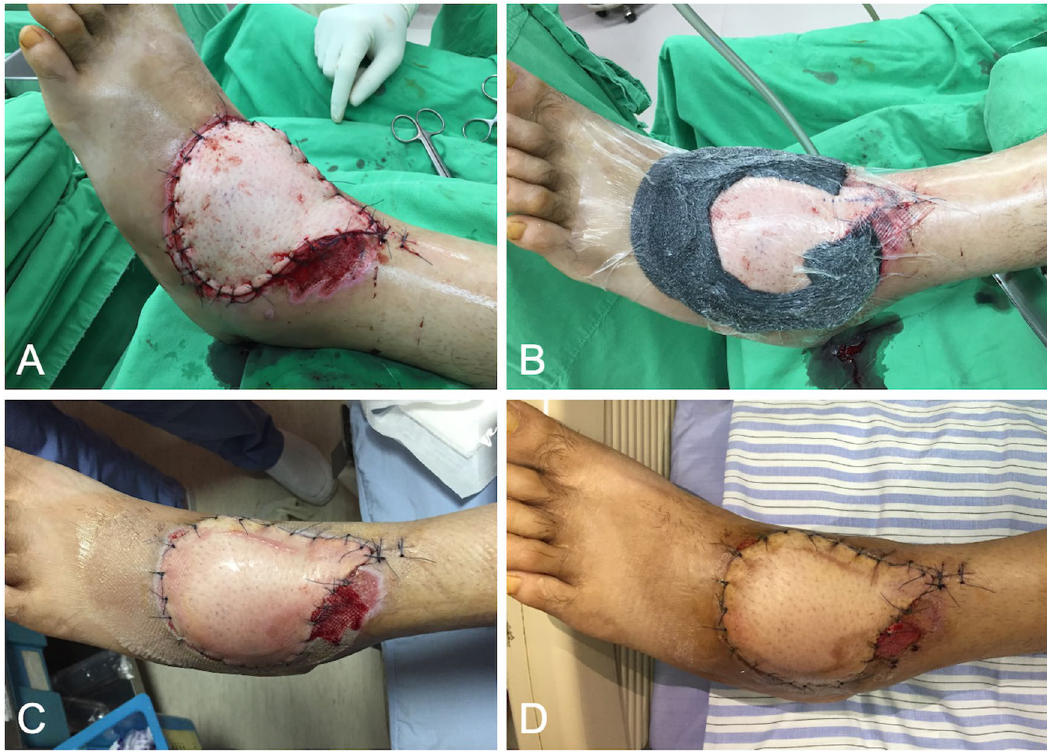
Figure 3. ( A ) An 8 × 11 cm defect over the dorsal foot was covered with free anterolateral thigh flap. ( B ) NPWT was applied immediately following surgery. ( C ) Mild maceration over the flap edge but normal perfusion while discontinuing the NPWT. ( D ) One week after discontinuation of